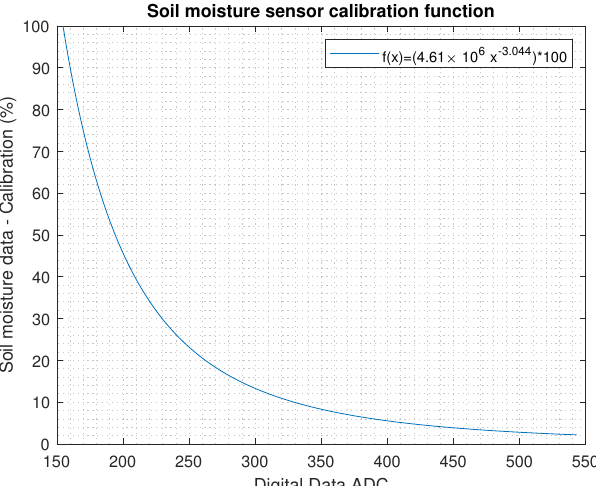
Figure 4. Calibration curve of the moisture sensor resulting from the gravimetric method; this calibration function is located inside the microcontroller of each